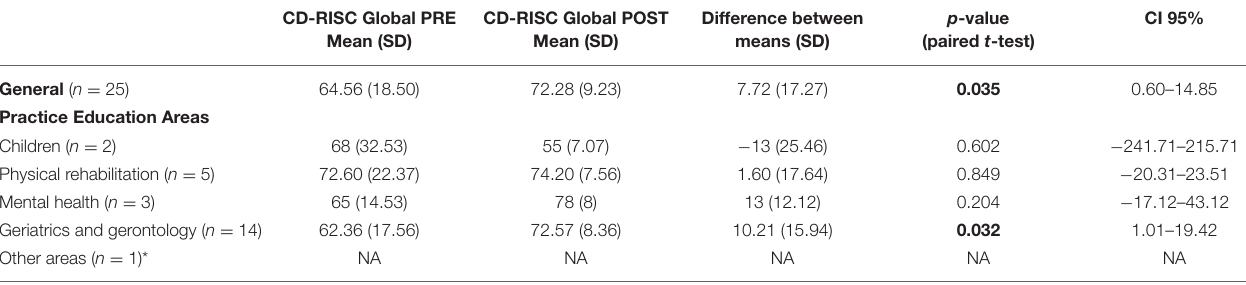
TABLE 4 | Practical training PRE-POST scores of global resilience (CD-RISC 25) in male students ( n =